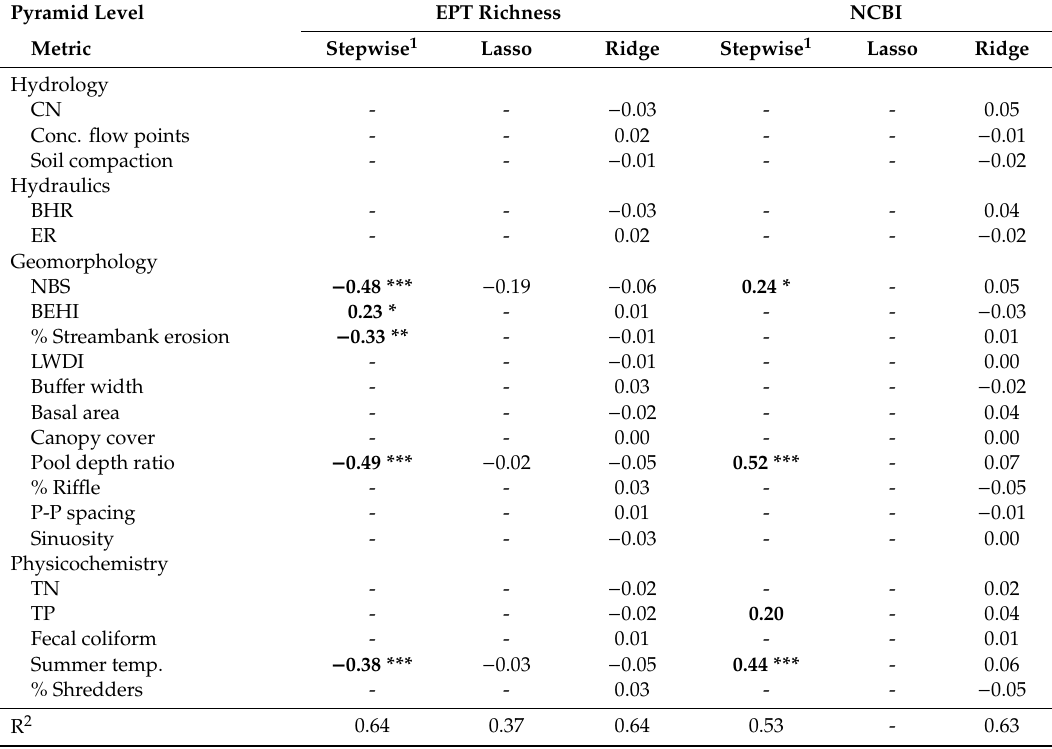
Table 3. Partial regression coe ffi cients and coe ffi cients of determination (R 2 ) resulting from stepwise, lasso, and ridge with the SQT dataset for EPT richness and the NCBI. Variables with higher weights are in bold ( ≥ | 0.20 | ). Asterisks correspond to values that are statistically significant at applicable alpha levels for stepwise (see below